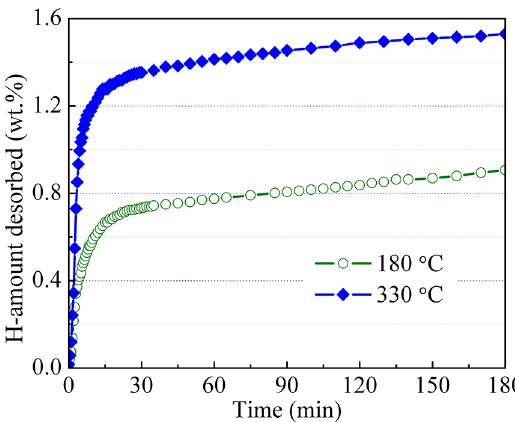
Figure 3. Time dependences of dehydrogenation for the as-milled Sr AlH + LiNH mixture at 180 and 330 °C, respectively 2 7 2